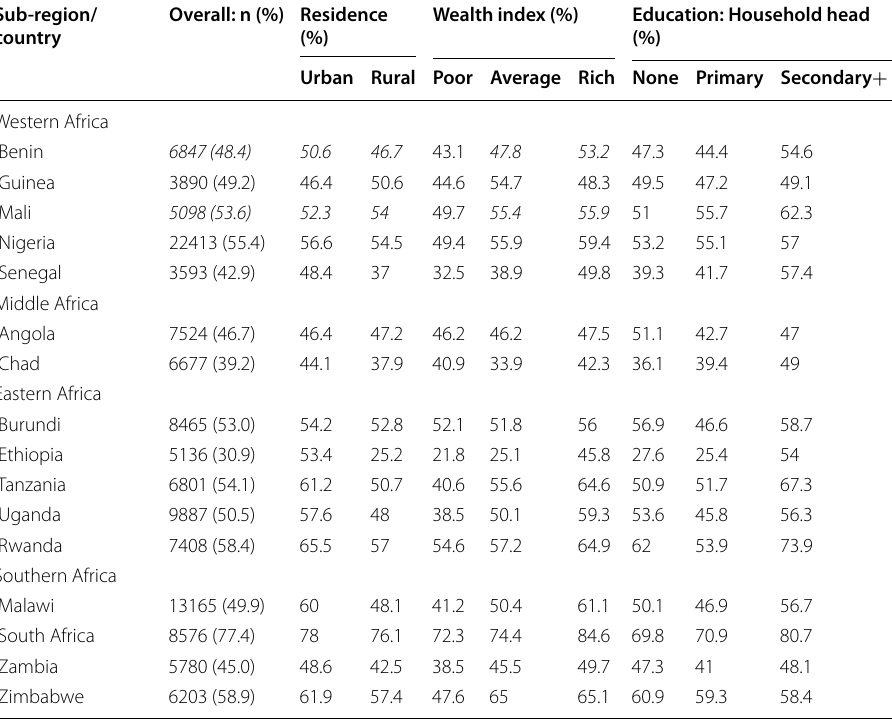
Table 3 Distribution of Isolation capacity in selected African countries Sub-region/ Overall: n (%) Residence Wealth index country (%)